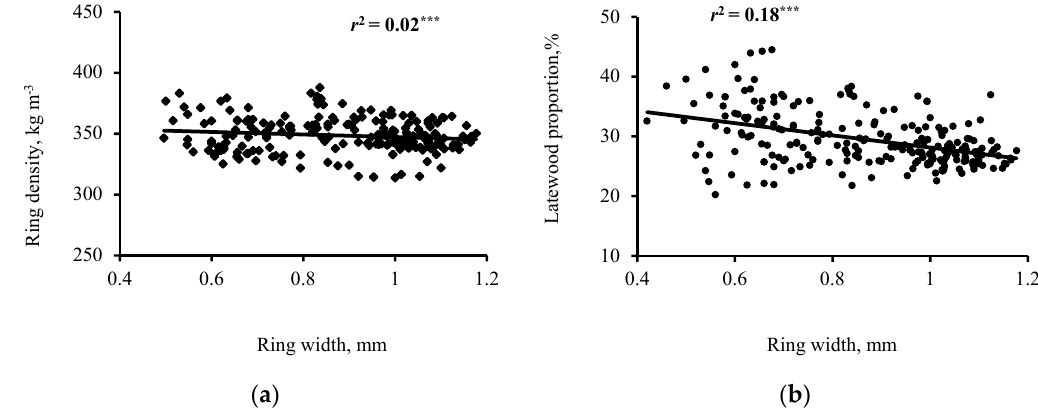
Figure 4. Variation of mean ring density ( a ) and latewood proportion ( b ) with mean ring width for 44 T. occidentalis trees. Significance level: *** p < 0.001 .